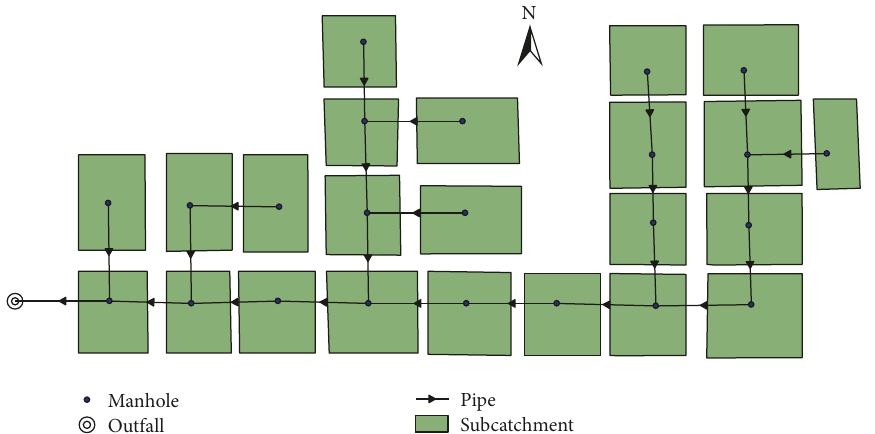
Figure 7: Subcatchments and conduits of study area.